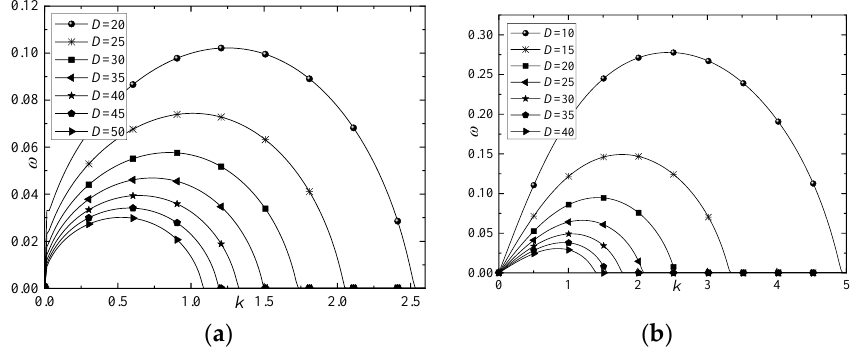
( d ) Figure 4. Effects of Eu on ( a ) sheet instability for sinuous mode, ( b ) sheet instability for varicose mode, ( c ) maximum growth rate, and ( d ) dominant wavenumber. The effect of the dimensionless distance D on the instability of the viscoelastic liquid sheet is further studied in the present study, as shown in Figure 5. According to Equation (8), the electric strength increases sharply as D decreases. In this situation, it is easy to conclude that the sheet could become much more unstable in both modes if the distance